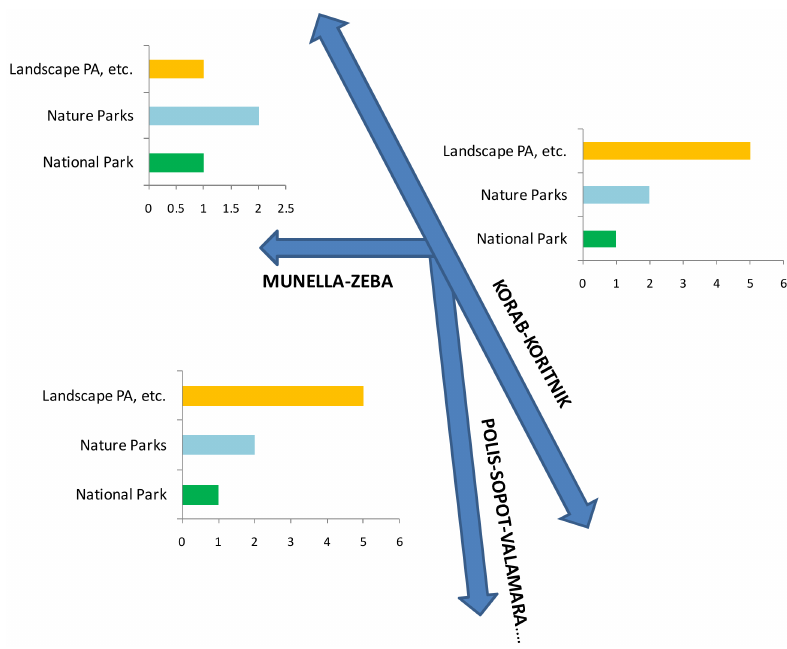
Figure 2. Protected areas along the selected